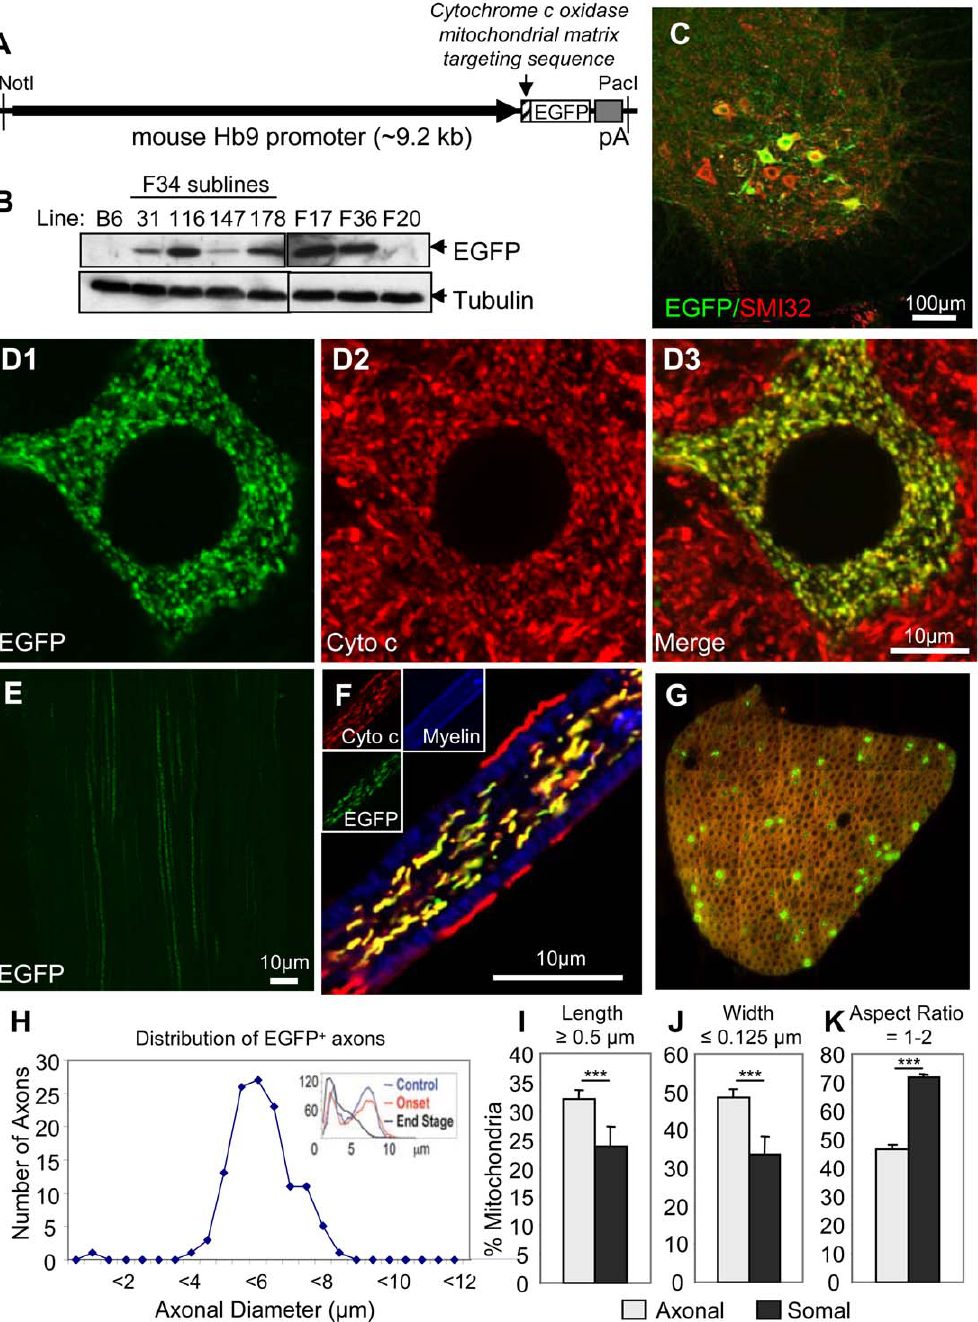
Figure 1. Generation of a novel transgenic mouse with mitochondria labeled uniquely in motor neurons. (A) Schematic of Hb9- MitoEGFP transgene. (B) Immunoblot of spinal cord homogenates of Hb9-MitoEGFP founders (F34, F17, F36, F20) and F34 sublines probed for EGFP and tubulin (loading control). (C–G) MitoEGFP (green) expression in spinal cord motor neurons (C & D), sciatic nerve (E), and L5 motor axons (F & G) labeled with SMI32 (C, red ), cytochrome c (D & F, red ), and Fluoromyelin Red (F & G, blue/red ). Note that mitochondria have typical tubular and punctate morphologies and MitoEGFP expression is excluded from Schwann cells. (G & H) 15% of large caliber ( . 4.5 m m) L5 motor axons express MitoEGFP in 12 months animal. The expected biphasic distribution of axonal caliber in adult C57Bl/6 mice is indicated in the upper right corner. Comparison of axonal and somal mitochondrial length (I), width (J) and aspect ratio (K) in Hb9-MitoEGFP mice. Scale bars, 10 m m.